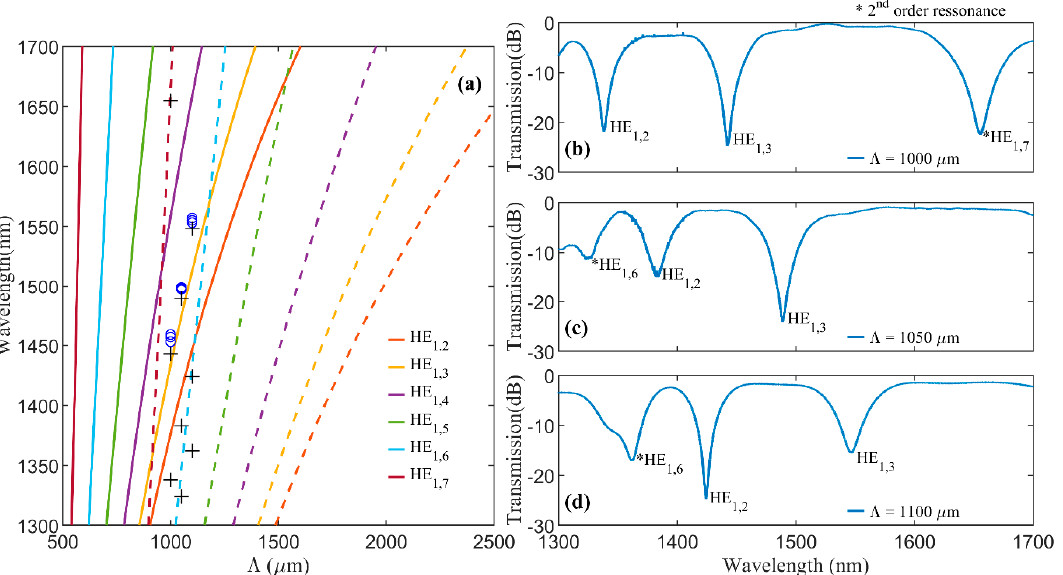
Figure 6. Resonant wavelengths as a function of the grating period ( a ) for the first (solid lines) and second order (dash lines) coupling of azimuthally symmetrical cladding modes HE 1,2 to HE 1,7 . Markers represent the experimental resonant wavelengths of the produced LPGs that (o) correspond to the attenuation dips of the spectra of Figure 2 and ( + ) to the attenuation dips of the transmission spectra of LPGs produced with a periods of ( b ) 1000, ( c ) 1050 and ( d ) 1100 µ m and a length of 14, 14 and 19 periods, respectively. The lengths of the LPGs were chosen in order to show more dips.